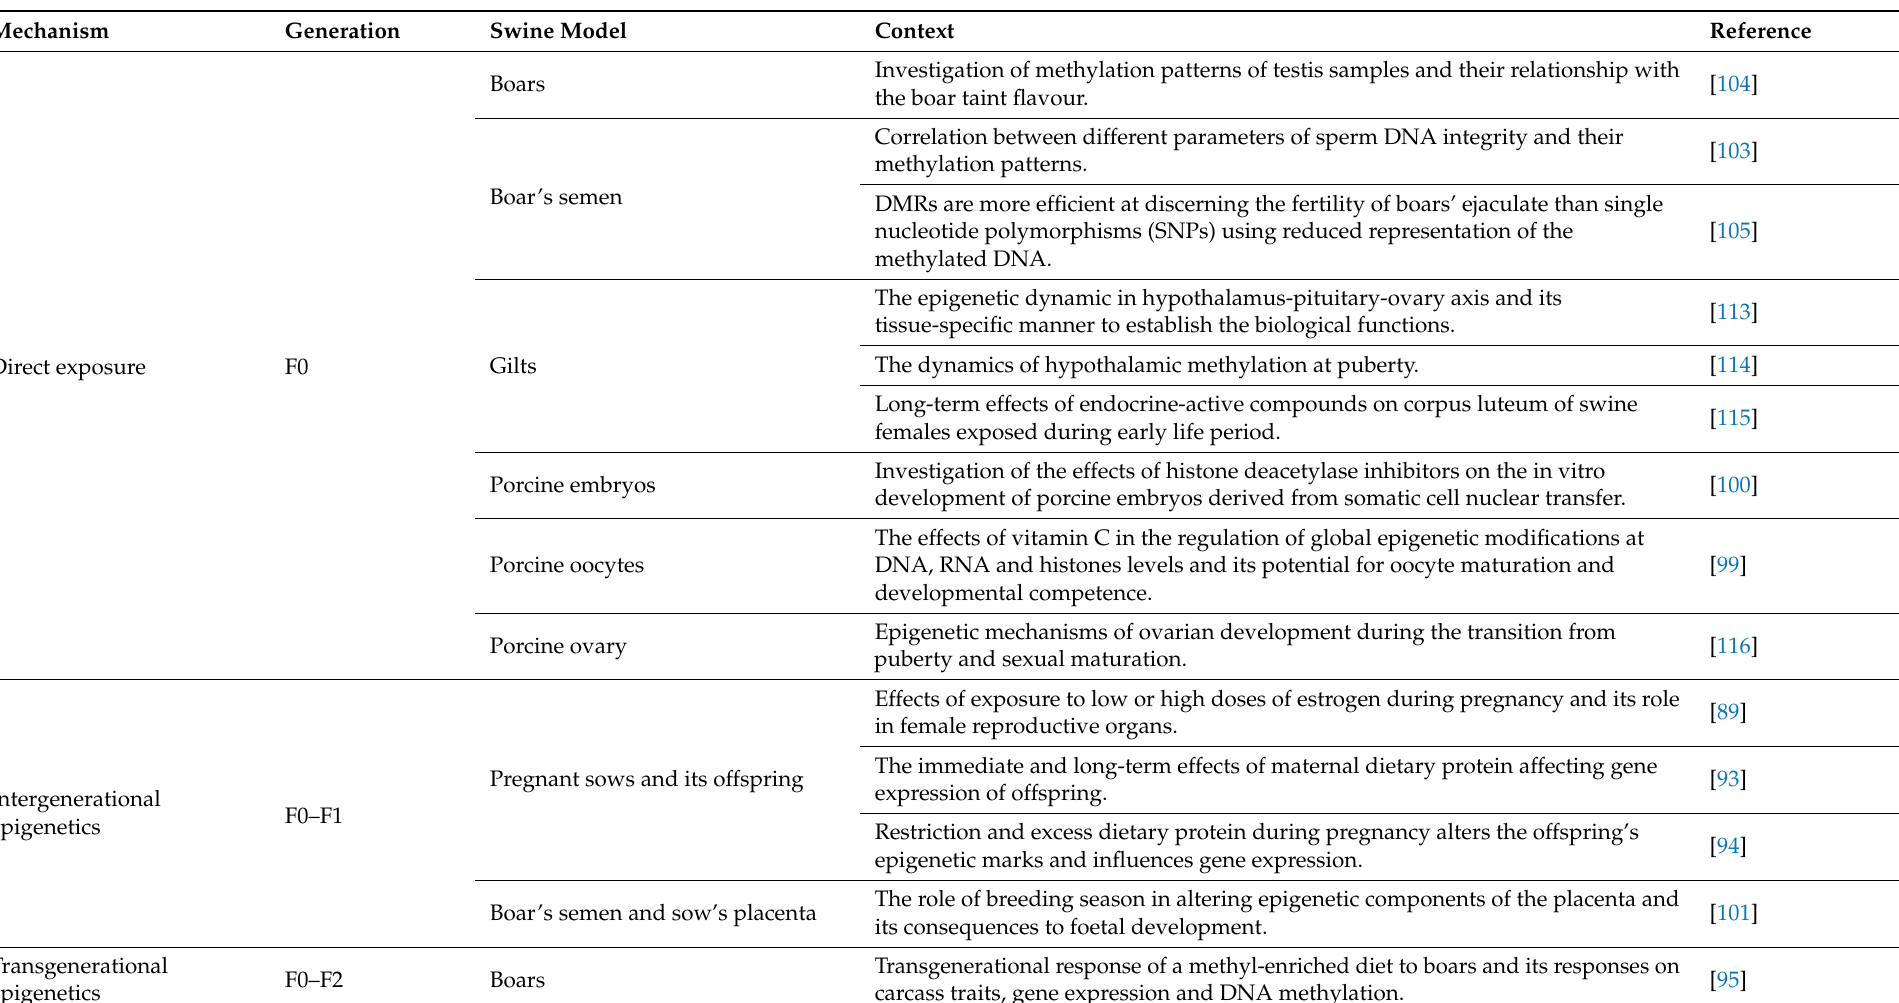
Table 1. Studies related to swine epigenetics in different experimental